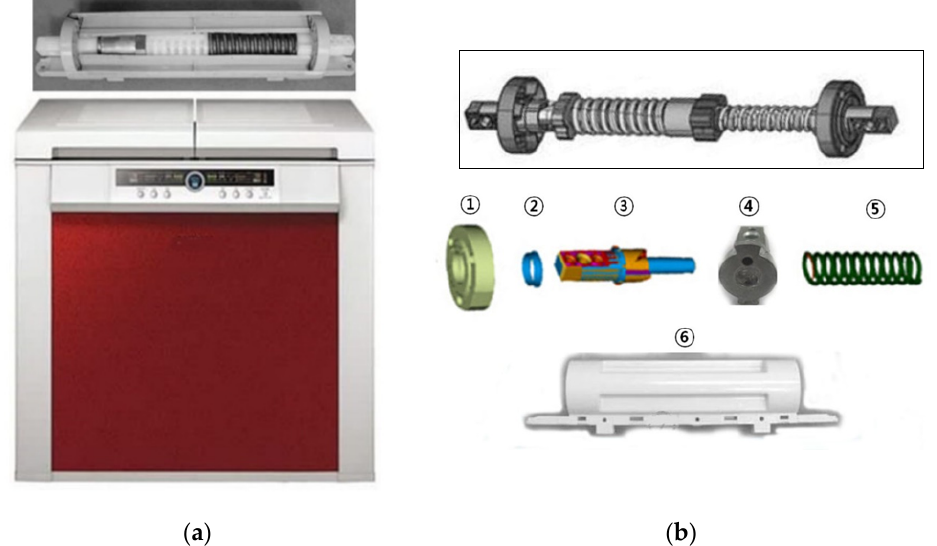
Figure 5. A domestic refrigerator ( a ) and HKS ( b ) and its parts: (1) kit cover, (3) support, (4) torsional shaft (cast iron), (5) spring, and (6) kit housing (high-impact polystyrene, HIPS).